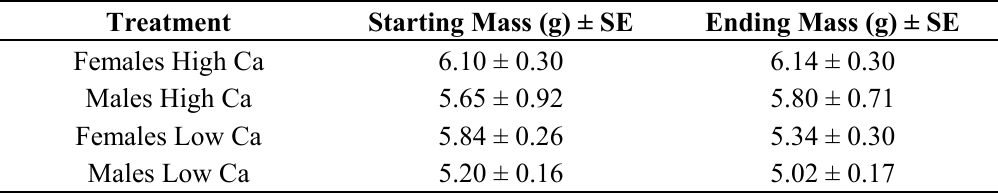
Table 2. Average gender-specific mass (g) of shrews in low and high calcium diet